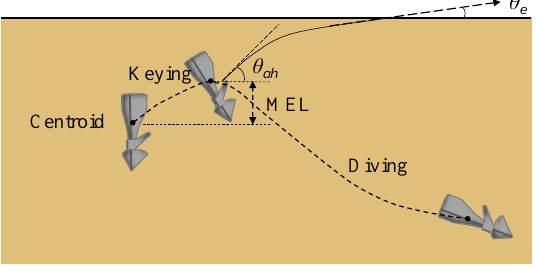
Figure 18. Keying, embedment loss, and diving of an OMNI-Max anchor.